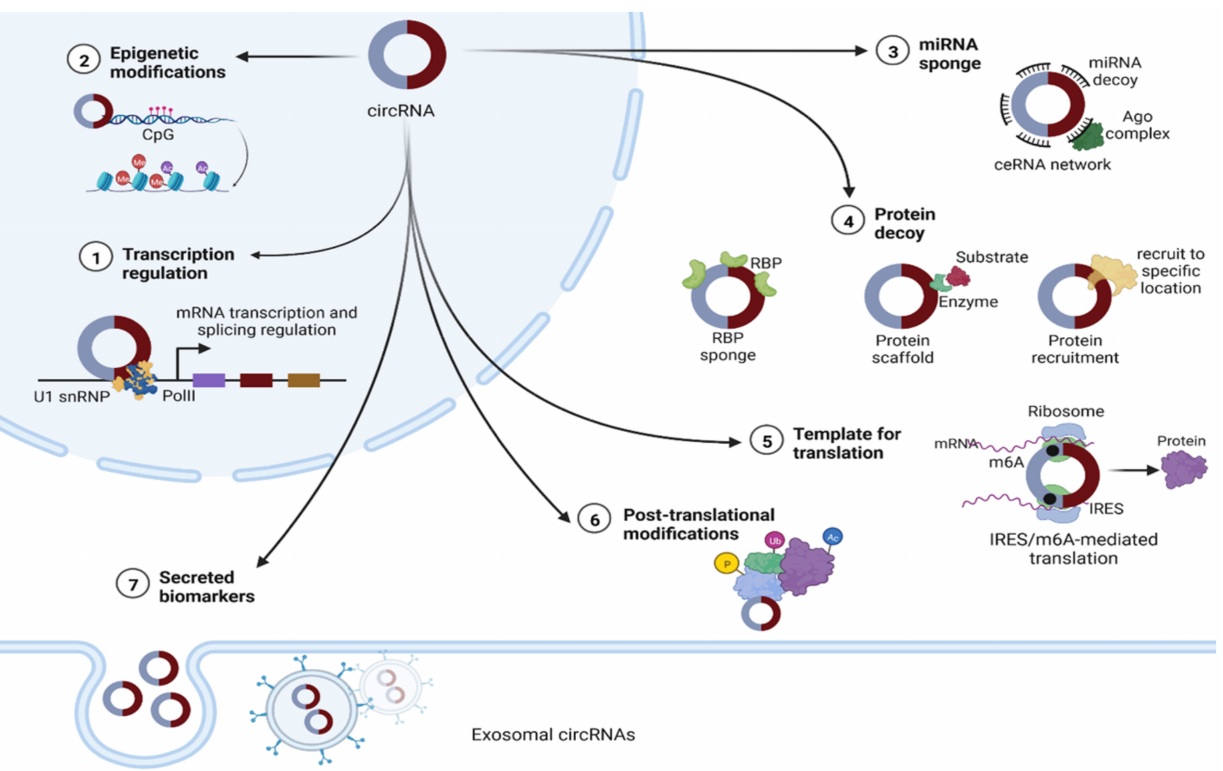
Figure 2. The putative functions of circRNAs. (1) The nuclear type can act as regulators of their host genes’ transcription, either by interacting with U1 small nuclear ribonucleoprotein (U1 snRNP) and enhancing RNA polymerase II (Pol II) function, or by recruiting methyl cytosine dioxygenase (TET1) to the promoter sequences [51]. (2) Epigenetic regulation, including DNA and histone modifications [51]. (3) In cytoplasm, circRNAs can act as microRNA sponges, leading to a disrupted competing endogenous RNA (ceRNA) network [16,50]. (4) CircRNAs can function as RNA binding protein (RBP) decoys or otherwise can act as modulators for specific RBPs’ half-life, promoting or reducing their degradation by proteasomes. Enabling the colocalization of enzymes to their substrates facilitates reaction kinetics. CircRNAs can also act as protein scaffolds. (5) CircRNAs with